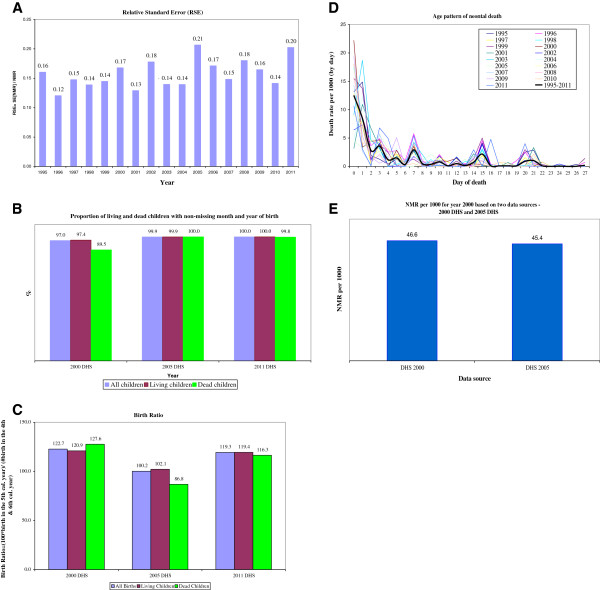
Indicators of completeness and quality of the Ethiopian neonates birth history data: 2000, 2005 and 2011 DHS. (A) Relative standard error. (B) proportion of living and dead children with non-missing month and year of birth. (C) birth ratio. (D) Age pattern of neonatal death. (E) NMR for year 2000 based on two data sources- 2000 and 2005 DHS.